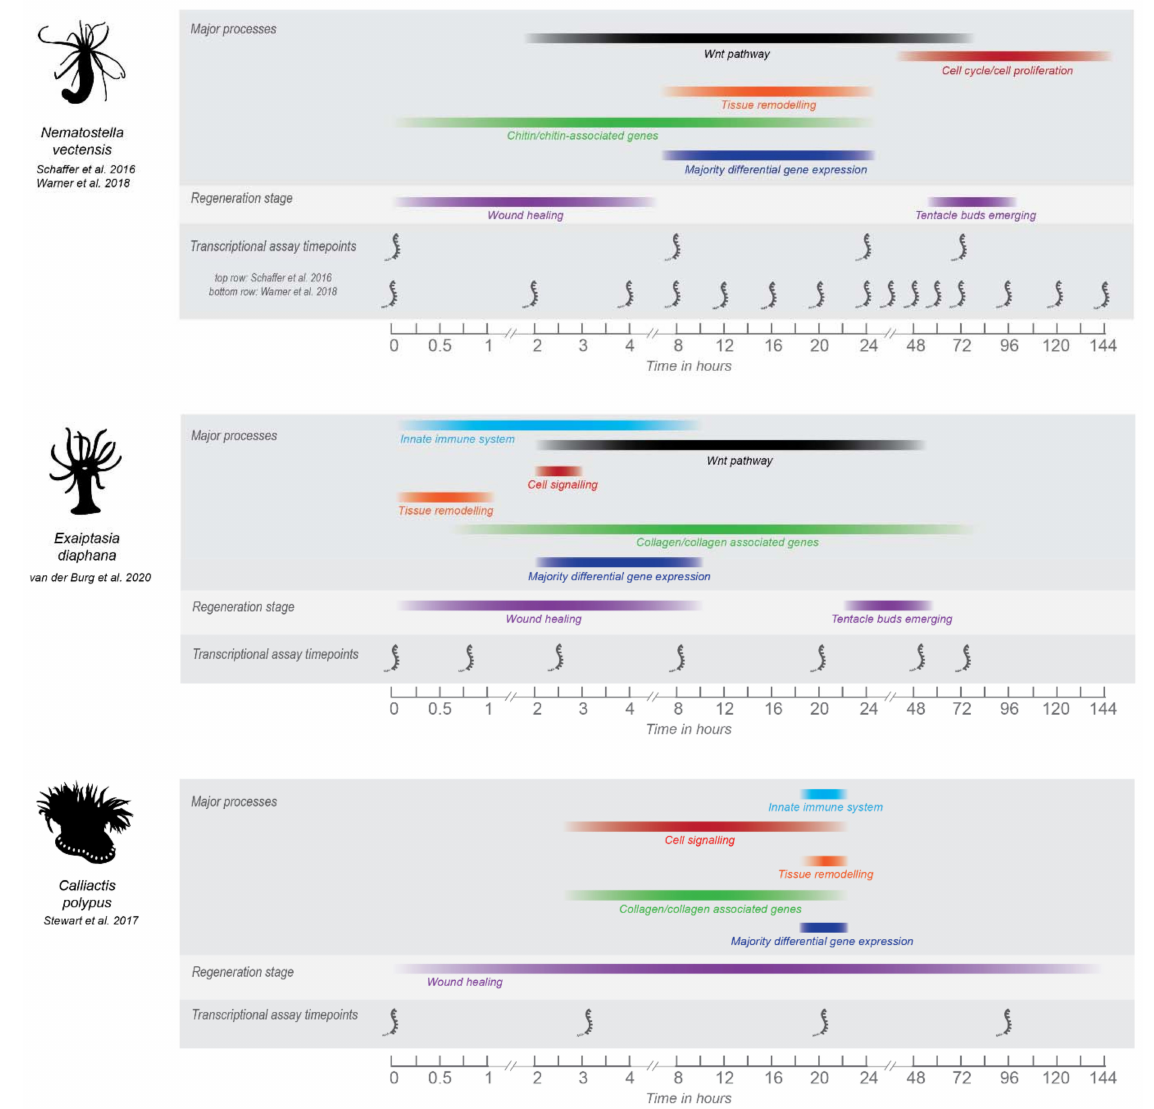
Figure 1. Overview of the major processes in regeneration as determined by transcriptomic studies performed in N. vectensis, E. diaphana and C. polypus . Major processes shown were chosen based on those highlighted by the authors in each study. Timepoints for which major processes are shown are based on either when the majority of differential gene expression is occurring for that process, or when significant gene ontology patterns are occurring. For visual ease, processes are shown as colored bars that span the timepoints for which gene expression was significantly detected. However, the gene expression occurring at timepoints between transcriptional data sets is unknown and so this should be considered a general overview only. Gene expression for each process may also be occurring at other timepoints in the regeneration datasets for each species, colored bars cover the timepoints for which significant expression or differential expression was occurring. Some of the major morphological processes are shown for context, timepoints for which are taken from the respective studies. For C. polypus and E. diaphana, timing of wound healing and regeneration need further refining and are based on visual evidence only. Nematostella wound healing and regeneration times are well-characterized on a cellular/morphological level. See Supplementary File S1, Table S1 for image copyrights and attributions and Table S2 for further information and source of data for this